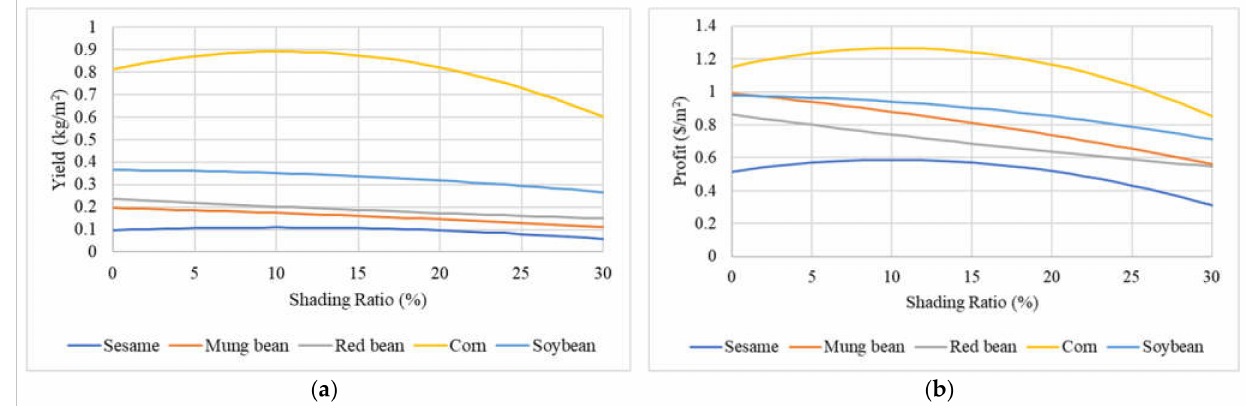
Figure 7. Estimation of crop production with different shading ratios: ( a ) yields of five crops; ( b ) profits of five